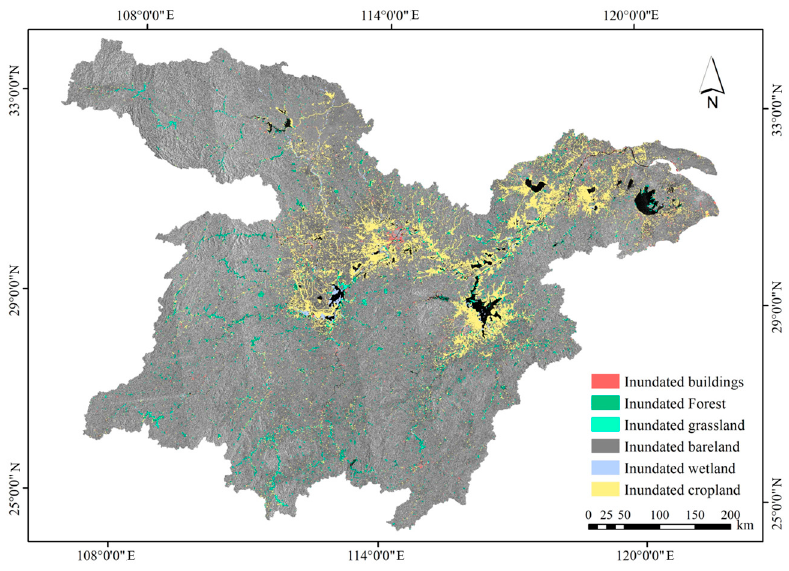
Figure 11. The distribution map of inundated land by land use in the study area.